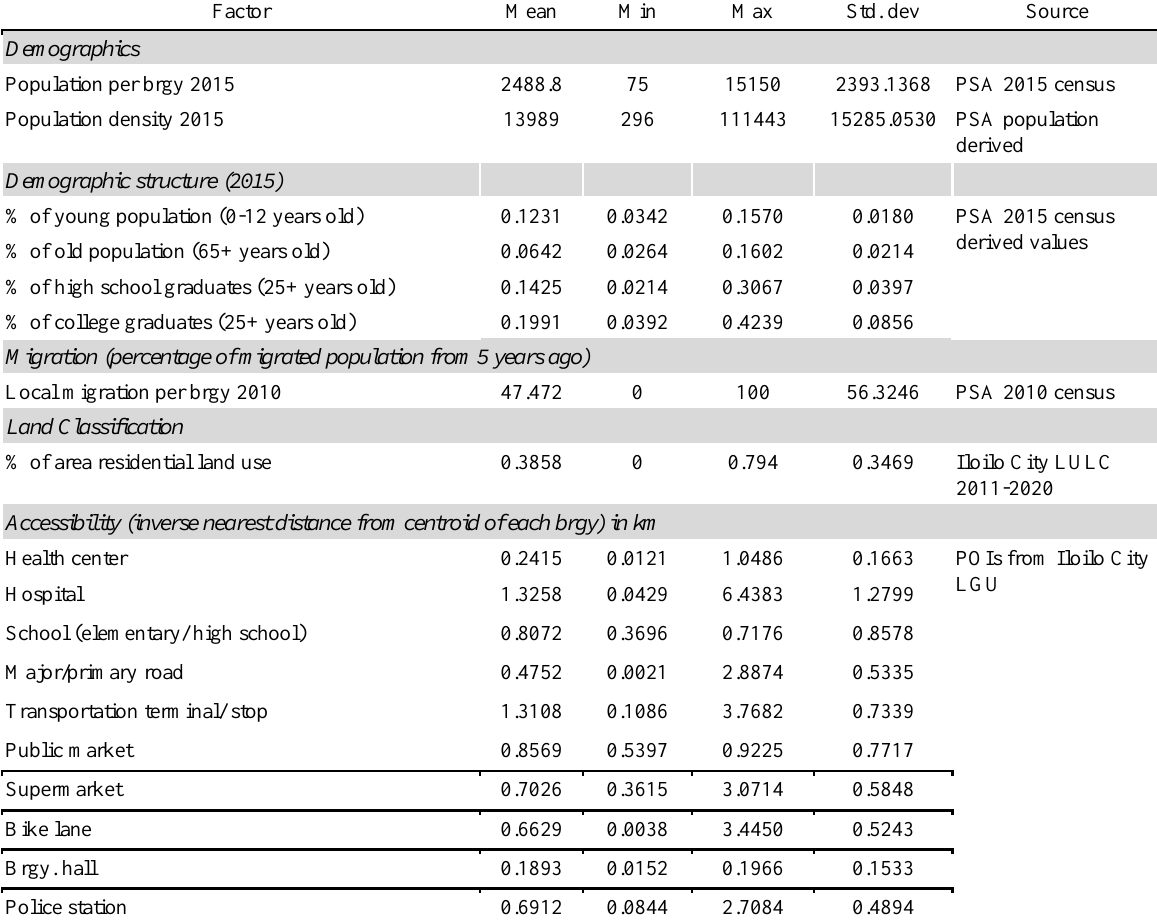
Table 1. Descriptive statistics of each